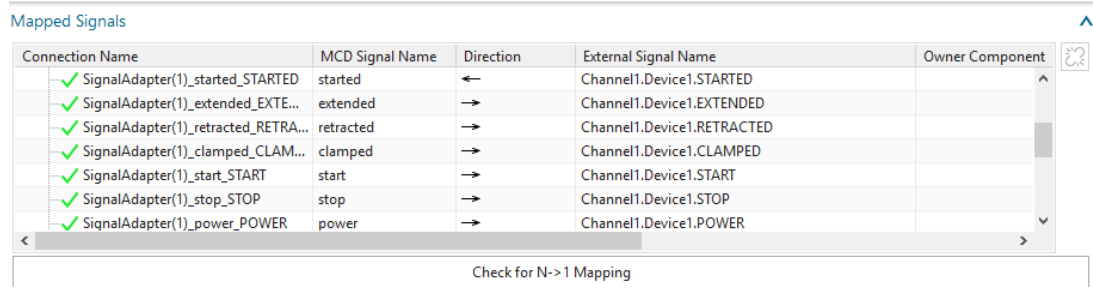
Figure 9. Mapping interface for the MCD and KEP-server signals.